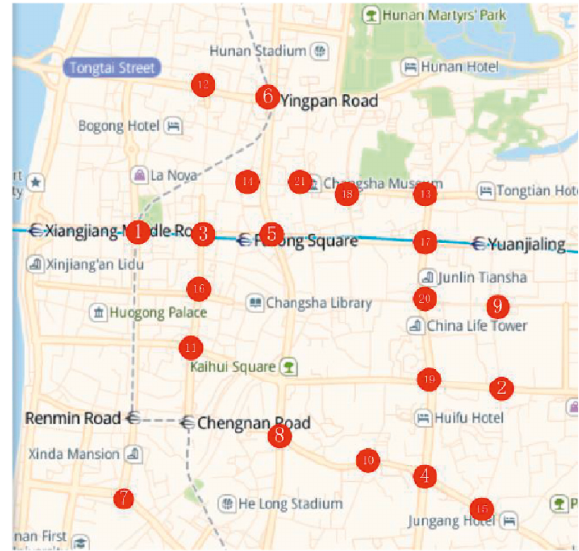
Figure 3: Intersections in Wuyi